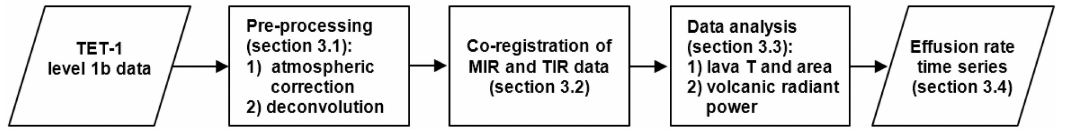
Figure 1. Basic scheme of the TET-1 processing